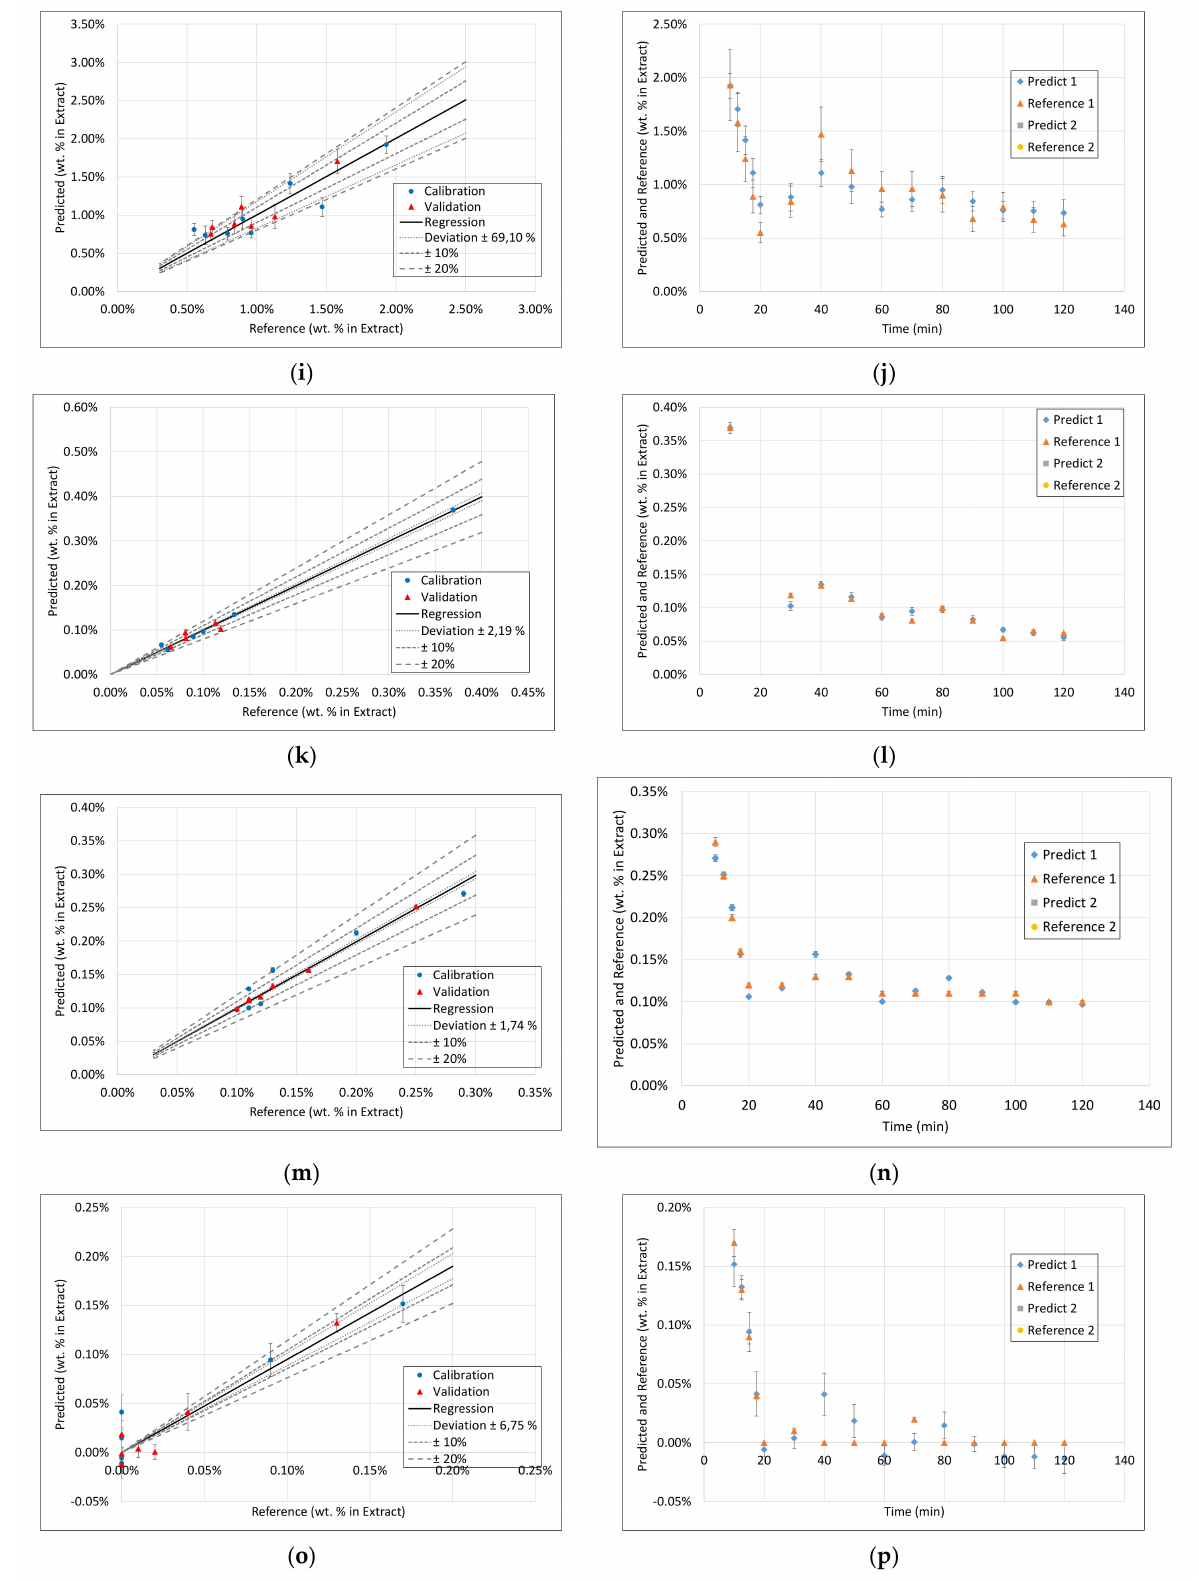
Figure A3. DAD half-normal plots and measured vs. predicted extraction profiles for ( a , b ) dry residue, ( c , d ) arbutin, ( e , f ) total phenolic content, ( g , h ) sugar monomers, ( i , j ) structural carbohydrates, ( k , l ) aminic acids, ( m , n ) proteins, and ( o , p )